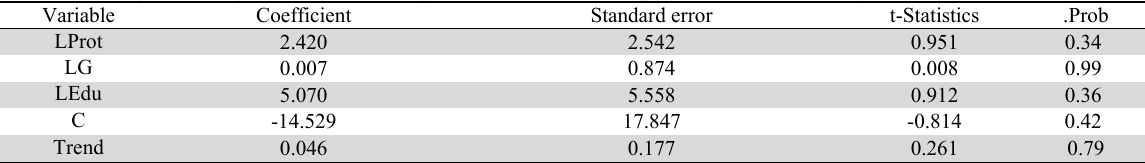
Investigating the long-run relationship between the total productivity on wages with time trend Variable Coefficient